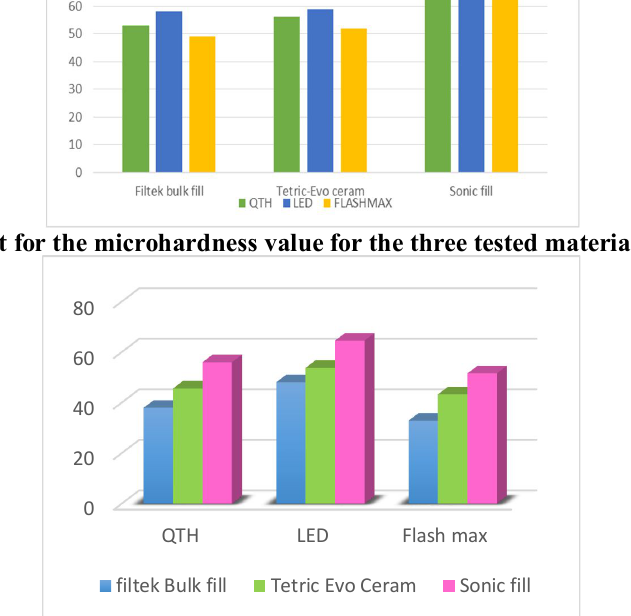
Figure 3: Chart for the microhardness value for the three tested materials bottom surfaces